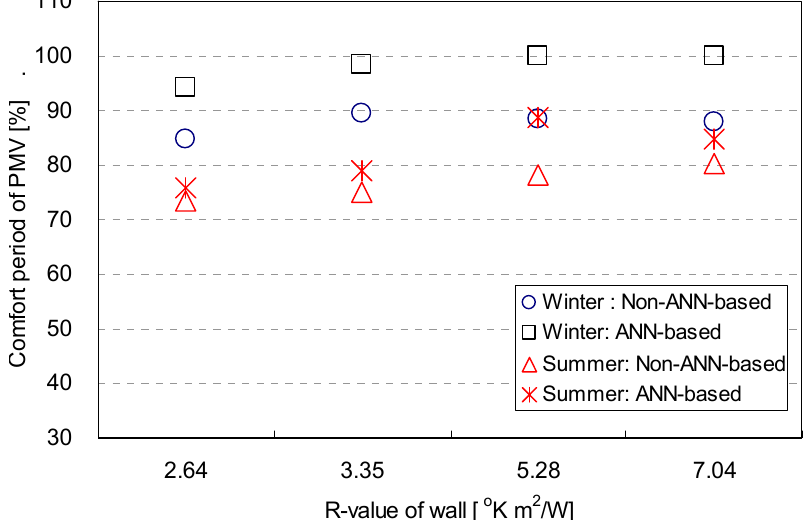
Figure 9. PMV comfort periods based on R -values of